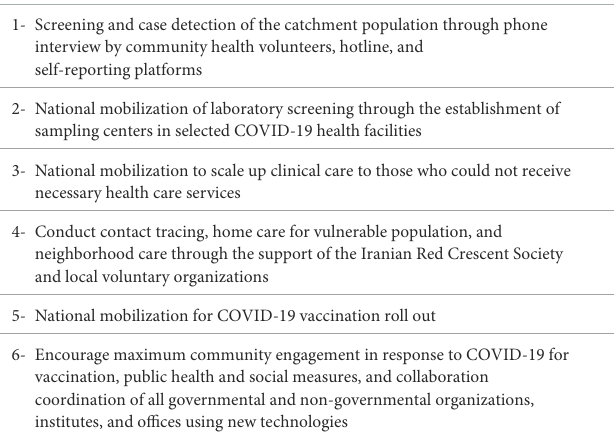
TABLE 1 Six steps of the national COVID-19 response